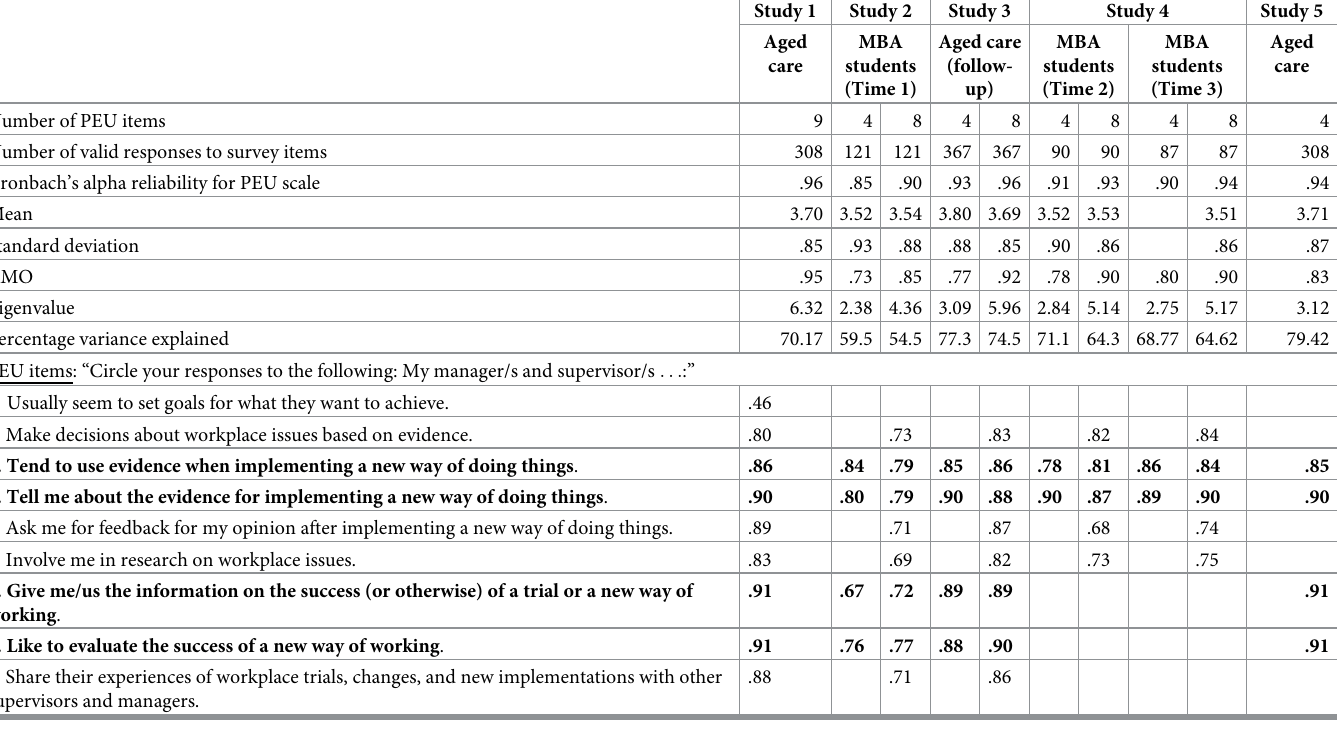
Table 2. Descriptive statistics, reliabilities, and factor analyses of perceived evidence use, 4 and 8 item scales (all studies).